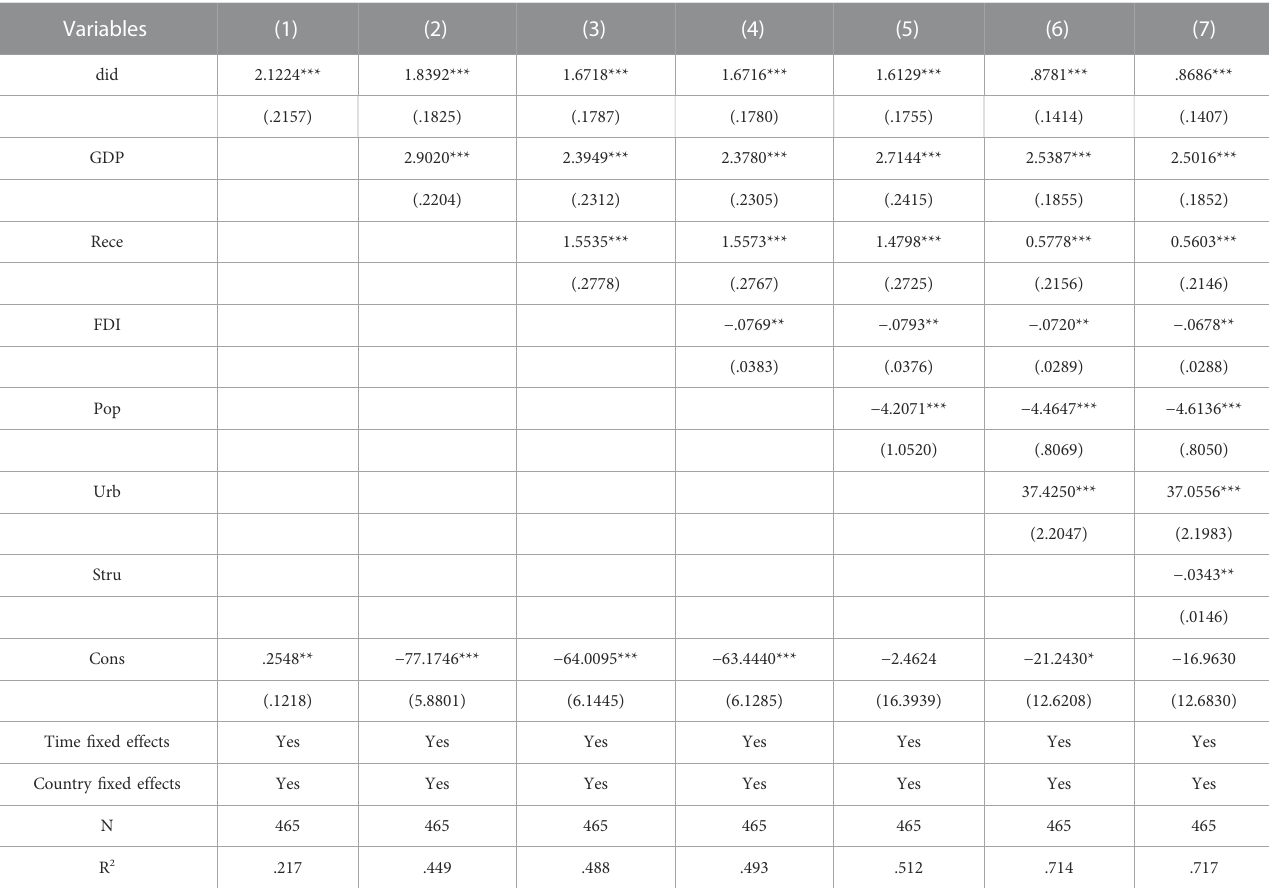
TABLE 4 Benchmark regression